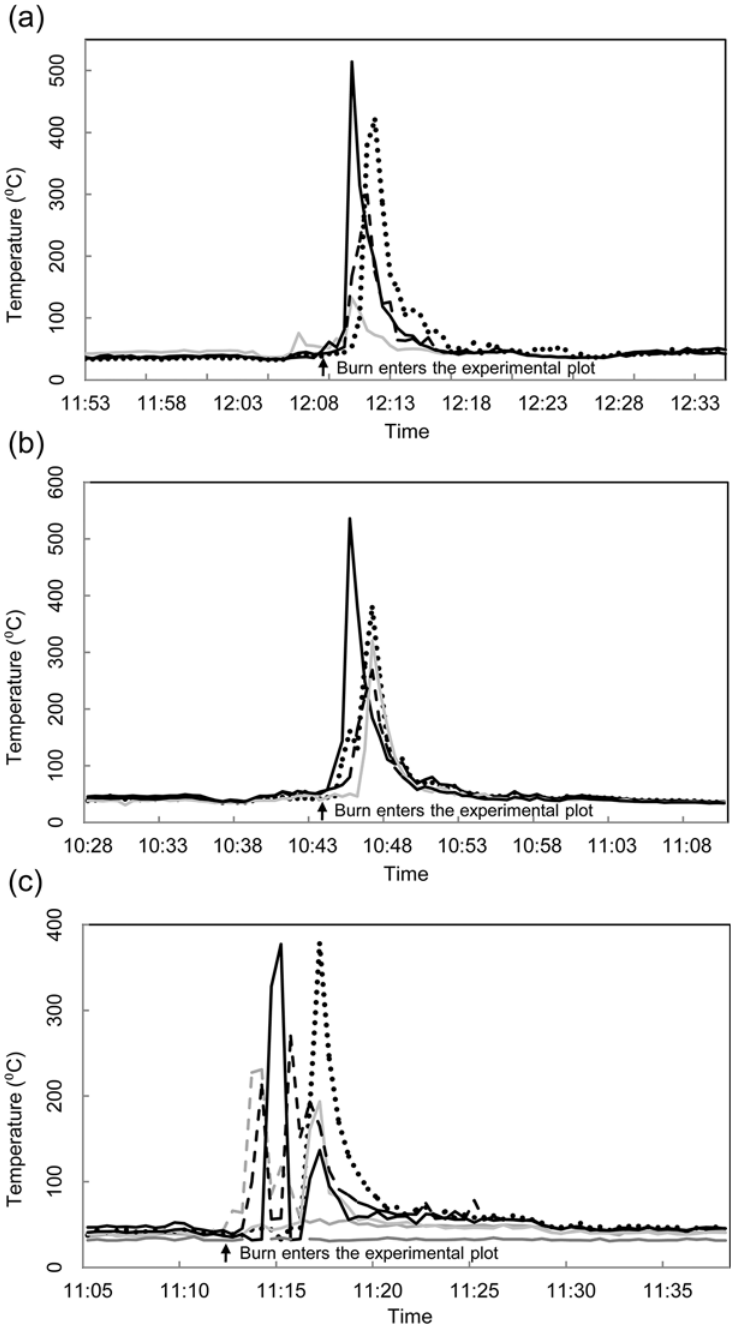
Fig 2. Soil surface temperatures as estimated using a non-contact infrared thermometer during controlled burning at the Ordway-Swisher Biological Station, Putnam County, Florida, July, 2012. (a) July 5 th , 2012; (b) July 6 th , 2012; (c) July 26 th , 2012. Flat grey line in (c) is an unburned location monitored during the controlled